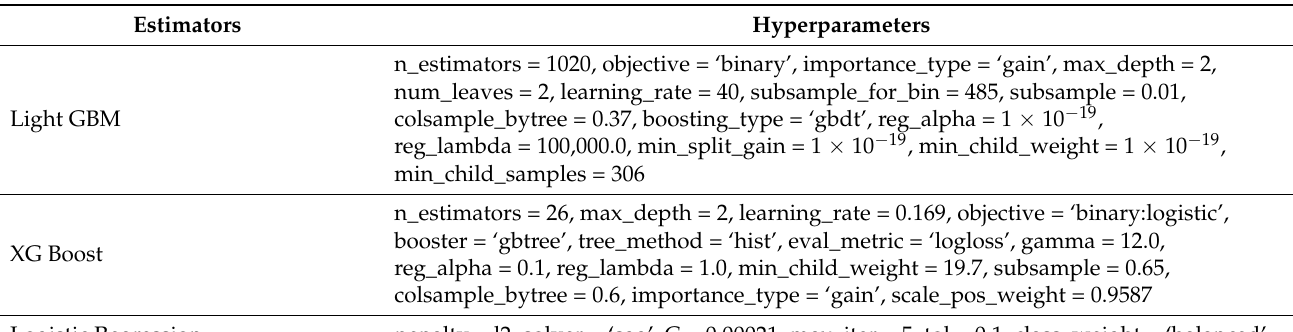
Table 4. Hyperparameters of weekly models.